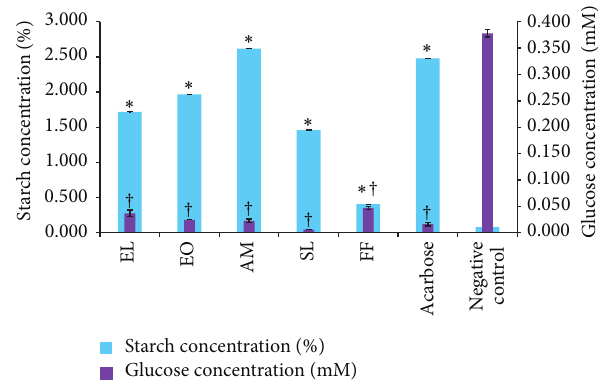
Control 5115.73 ± 3.91 b Valuessignificantly( 𝑃 < 0.05 )lowerthancontrol(acarbose); [] methanolic extracts; ( ) aqueous extracts. Table 4: Kinetic parameters of methanolic and aqueous plant extracts on 𝛼 -glucosidase activity invitro. Plant extracts